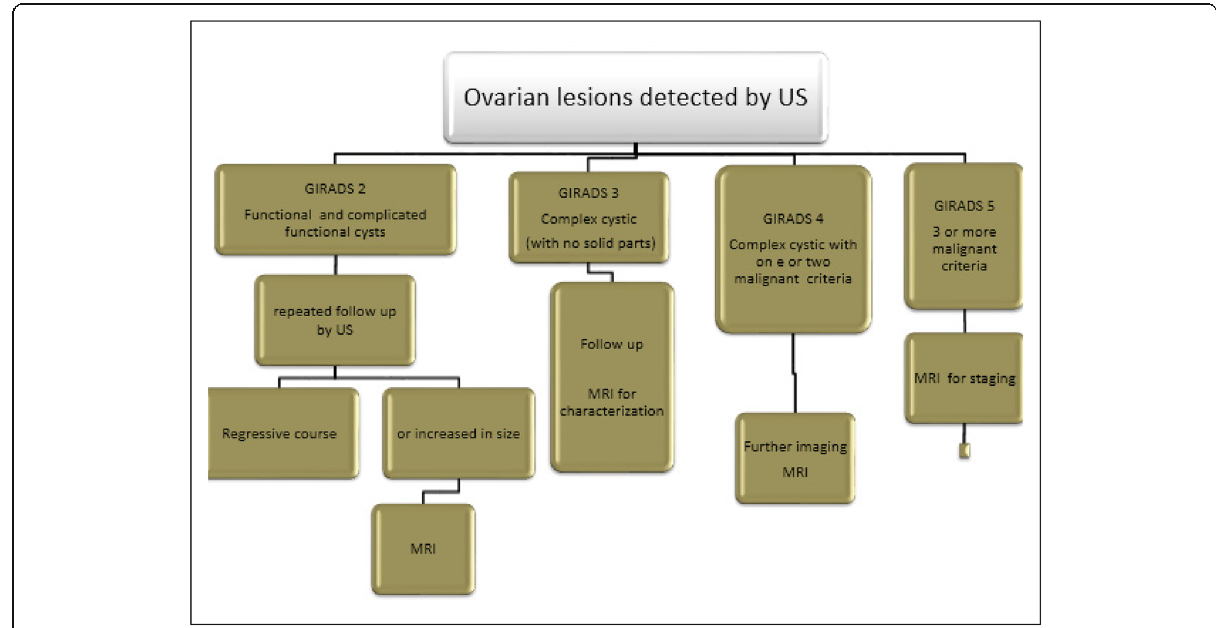
Fig. 1 Suggested algorithm for the diagnosis of ovarian